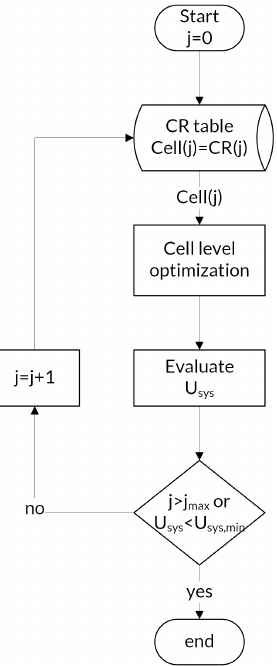
Figure 6. The implemented algorithm for system level